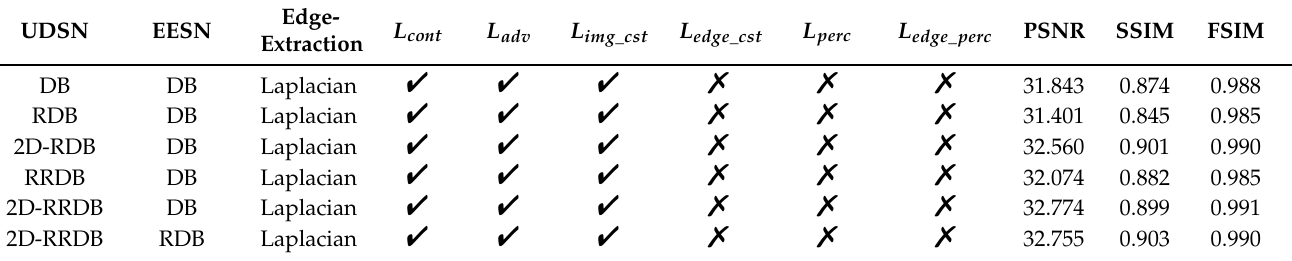
Table 4. Ablation